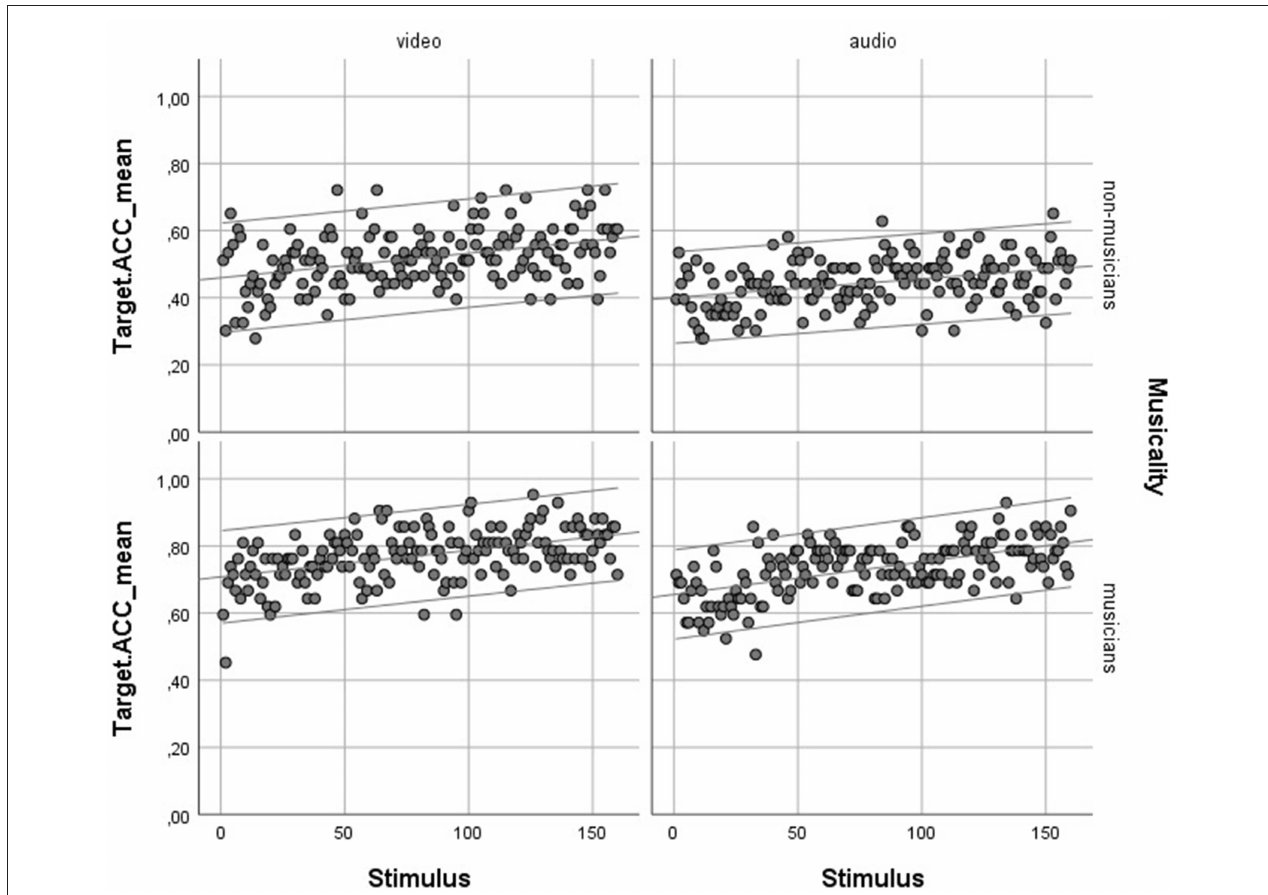
FIGURE 4 | Learning curves for musicians and non-musicians in Audio (auditory-only) and Video (auditory-visual) conditions.